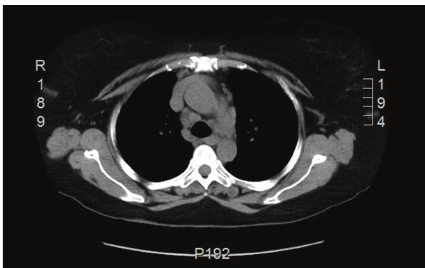
Figure 2: Follow-up thorax CT demonstrating resolution of medi- astinal lymph nodes.